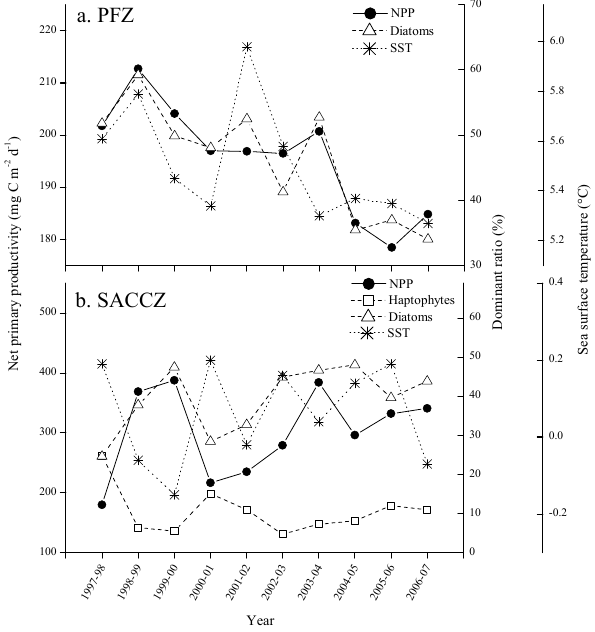
Fig. 3. Relationships between NPP, dominant phytoplankton groups and SST for (a) PFZ and (b) SACCZ from 1997 to 2007 during summer.